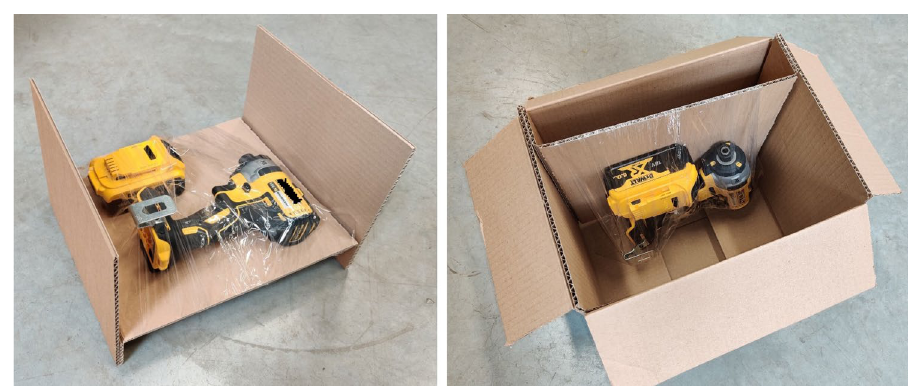
Fig. 2 Example of suspension packaging